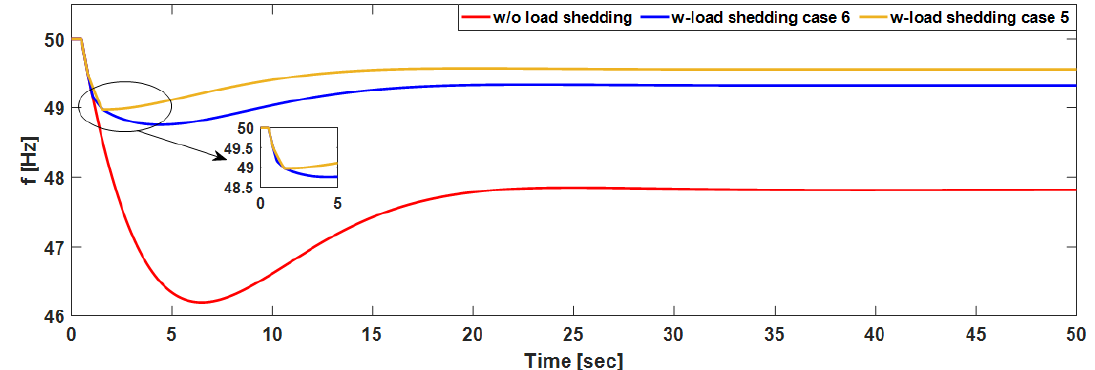
Figure 9. Frequency behavior in the third scenario: a comparison between cases 5 &